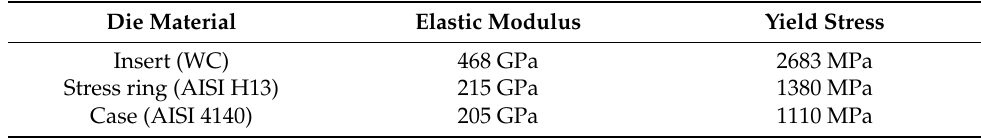
Table 4. Material properties of the forging dies.